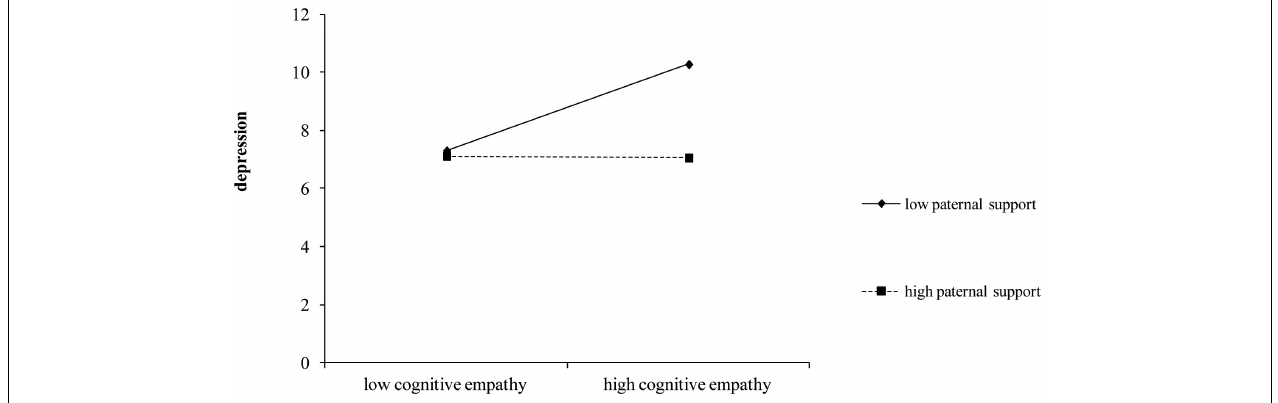
FIGURE 4 | Moderating effect of paternal support on the relationship between cognitive empathy and